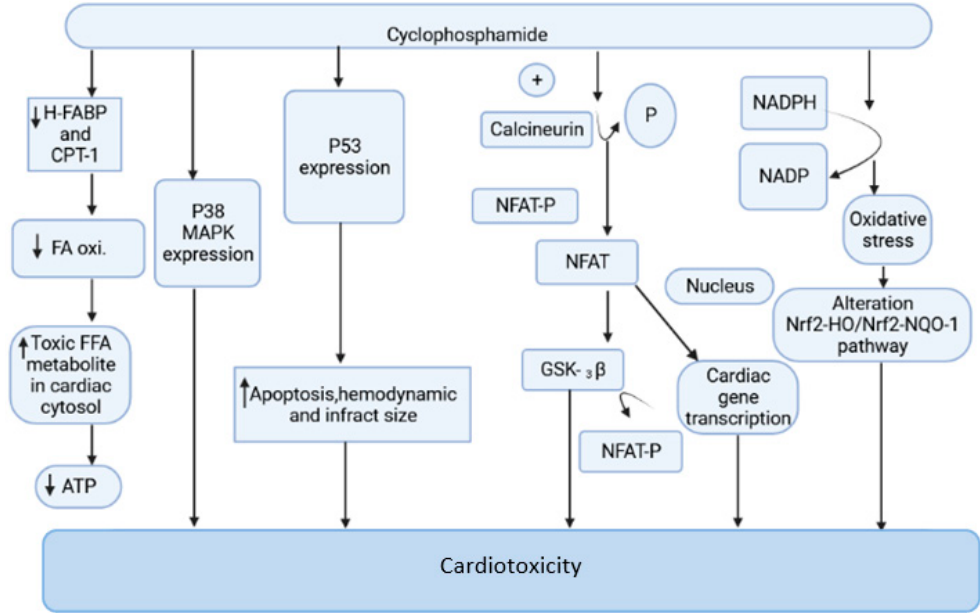
Figure 1. The mechanism of cyclophosphamide-mediated cardiac toxicity. Cyclophosphamide is activated by the cytochrome P-450 (CYP) enzyme in the liver, which transforms it into 4-hydroxycyclophosphamide. Aldo cyclophosphamide